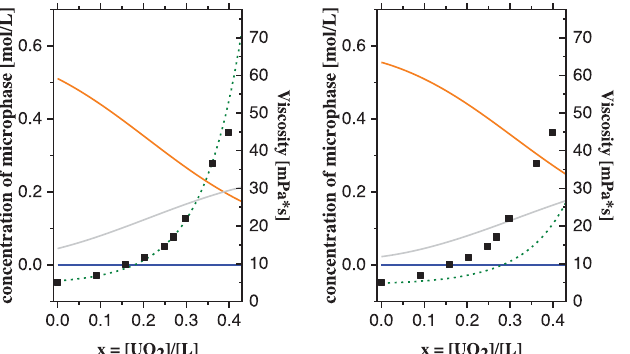
Fig. 18. The four possibilities to tackle the problem of viscosity increase. All formulation approaches are based on an increase in